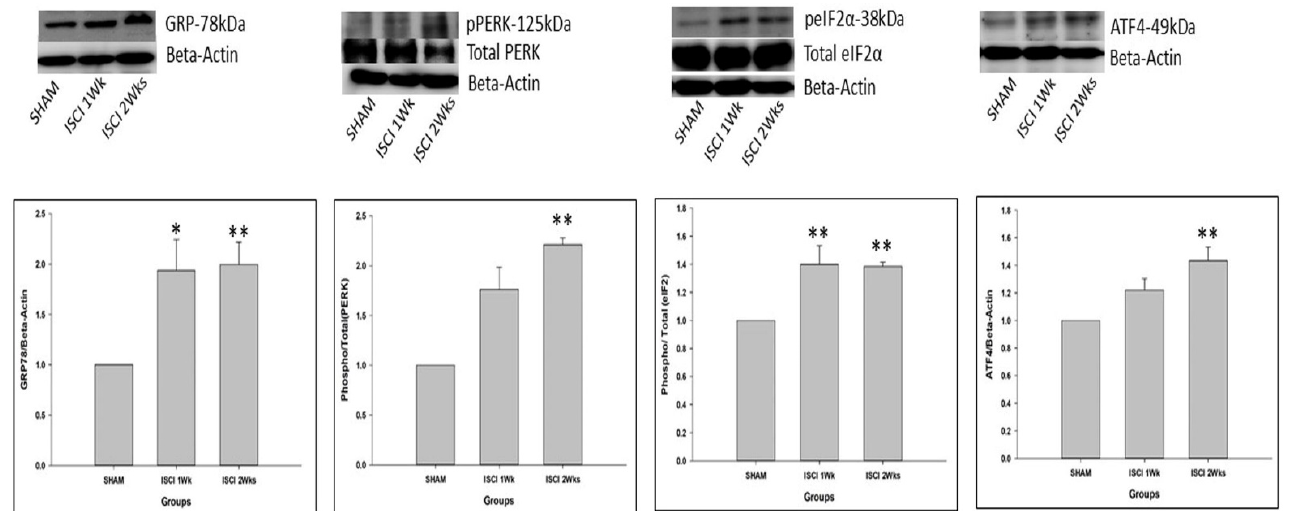
Figure 2. Western blot images with the quantification results showing the endoplasmic reticulum stress proteins by the PERK pathway. Data are expressed as mean ± standard error. * p < 0.05 versus the sham group; ** p < 0.01 versus the sham group.